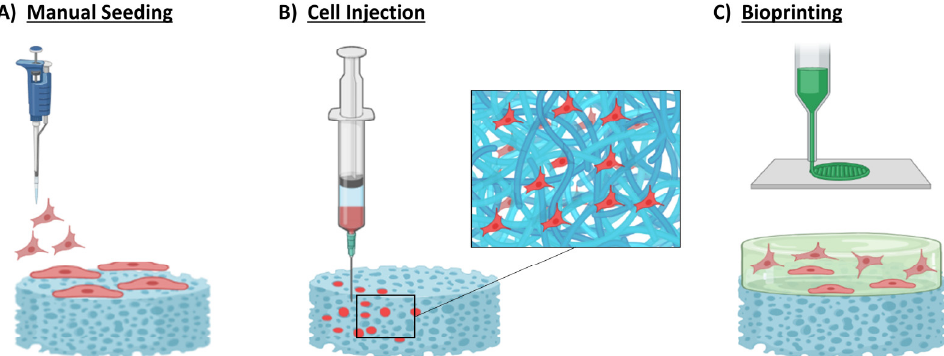
Figure 3. Schematic representation of techniques for biological scaffold cellularisation. ( A ) Manual seeding: cells resuspended in a fluid solution are deposited on the surface of the scaffold and cultured for maturation. ( B ) Cell Injection: Cells are injected throughout the thickness of the matrix creating a fully colonised graft. ( C ) Bioprinting: Cells are encapsulated in a biocompatible hydrogel and extruded with high accuracy on the surface of the graft providing specific spatial organisation.